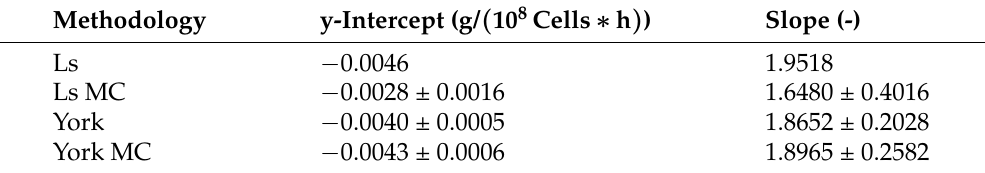
Table 3. Summary of the resulting regression parameters of the analyzed CHO cell fed-batch process with the standard parameter error for least squares (Ls) and York regression, with and without Monte Carlo (MC)